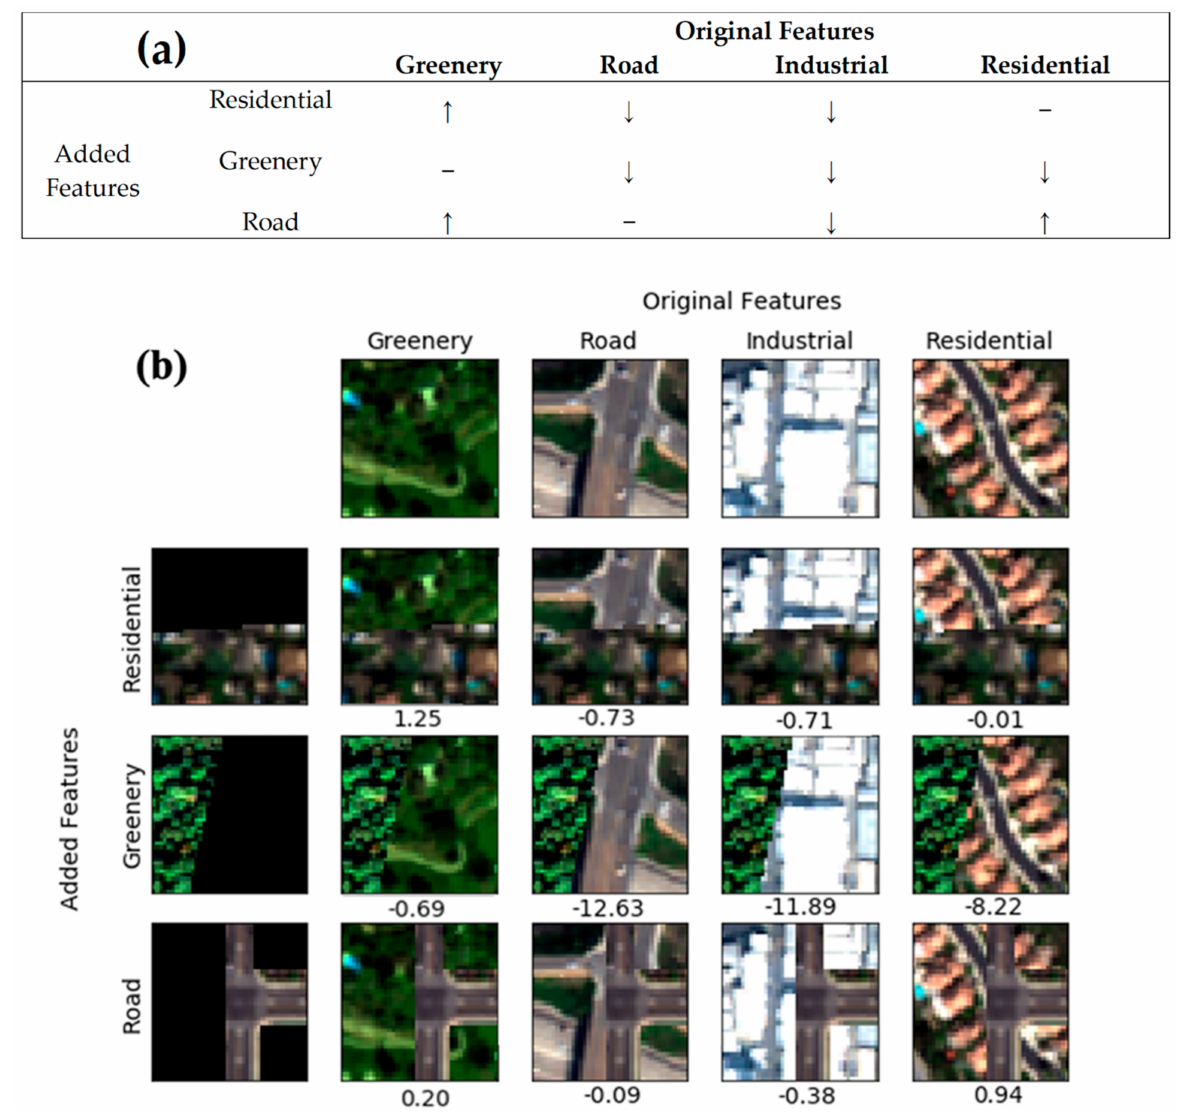
Figure 6. Feature contribution analysis ( a ) Hypothesis of expected changes in PM 2.5 concentrations ( µ g/m 3 ) when adding different urban features to original imagery; ( b ) Confusion table following the hypothesize in subfigure ( a ) using satellite images with and without synthesized residential, greenery, and road features. The columns represent the original satellite images of greenery, road, industrial, and residential from left to right. From top to bottom, the rows are partial residential, greenery and road images to be overlayed on original images. We demonstrate the differences of PM 2.5 levels between the original and synthesized images on the right hand of each subplot. The results in subfigure ( b ) are in line with our hypothesis demonstrated in subfigure ( a ) and support the conclusion that our model is learning the non-linear relations between urban objects and air pollution